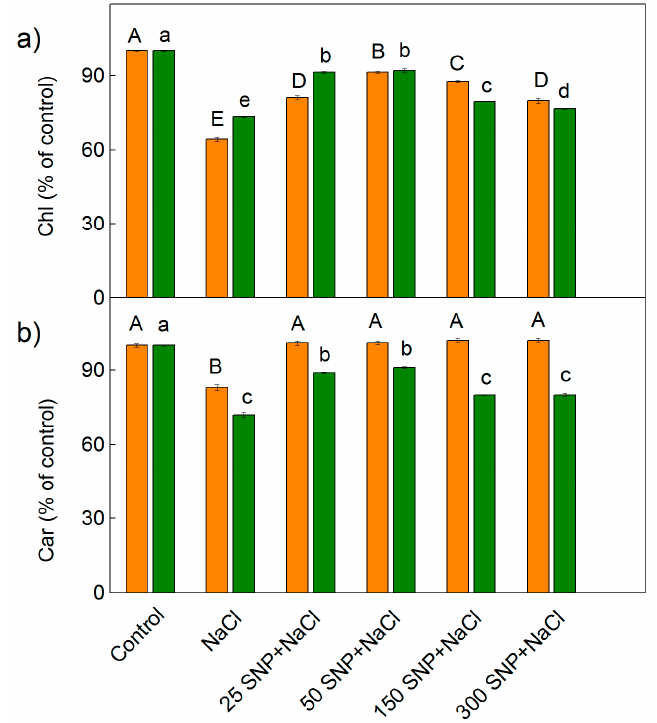
Figure 1. Effect of SNP on ( a ) the leaf total chlorophyll (Chl) and ( b ) carotenoid (Car) content of two sorghum varieties (Albanus—orange bars and Shamal—green bars) under salt stress. The values are expressed as a percentage of the respective control. The control values (100%) for Albanus are: Chl = 25,471 µ g g − 1 DW, Car = 4854 µ g g − 1 DW; for Shamal are: Chl = 24,854 µ g g − 1 DW, Car = 5450 µ g g − 1 DW. Mean values ( ± SE) were calculated from eight independent measurements. The significant differences among treatments at p < 0.05 are indicated by different letters (uppercase for Albanus and lowercase for Shamal).